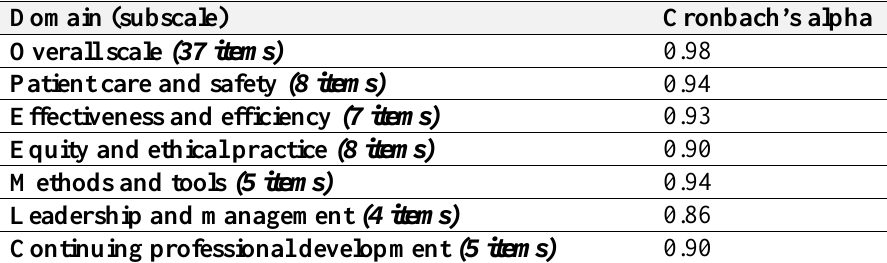
Table 2. Internal consistency of each domain (subscale) of the instrument